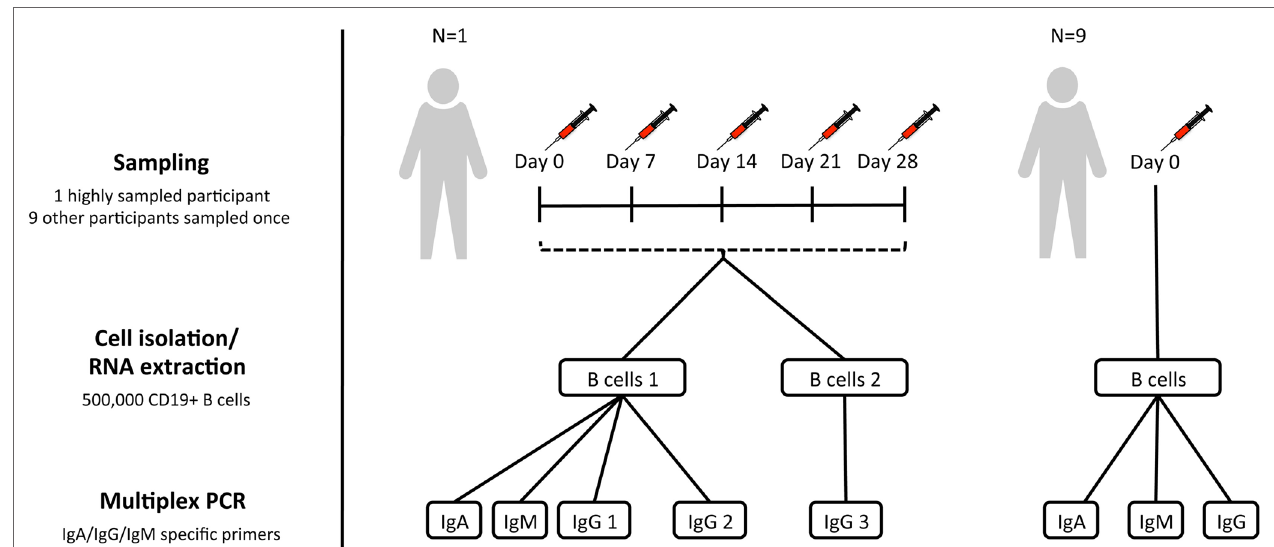
FigUre 1 | sampling scheme . For assessment of within-individual variation, one participant (participant AF01) had blood sampled at five timepoints 1 week apart (temporal replicates). For this participant, two aliquots of B cells were taken at each timepoint to give biological replicates. IgA, IgG, and IgM isotype-specific PCRs were all conducted for one of the biological replicates, but only IgG for the second biological replicate (IgG 3). Additionally, for this participant, IgG PCR replicates were also conducted at each timepoint for one of the biological replicates (IgG 2). For assessment of inter-individual variation, nine additional participants were sampled at a single timepoint, and had IgA, IgG, and IgM PCRs